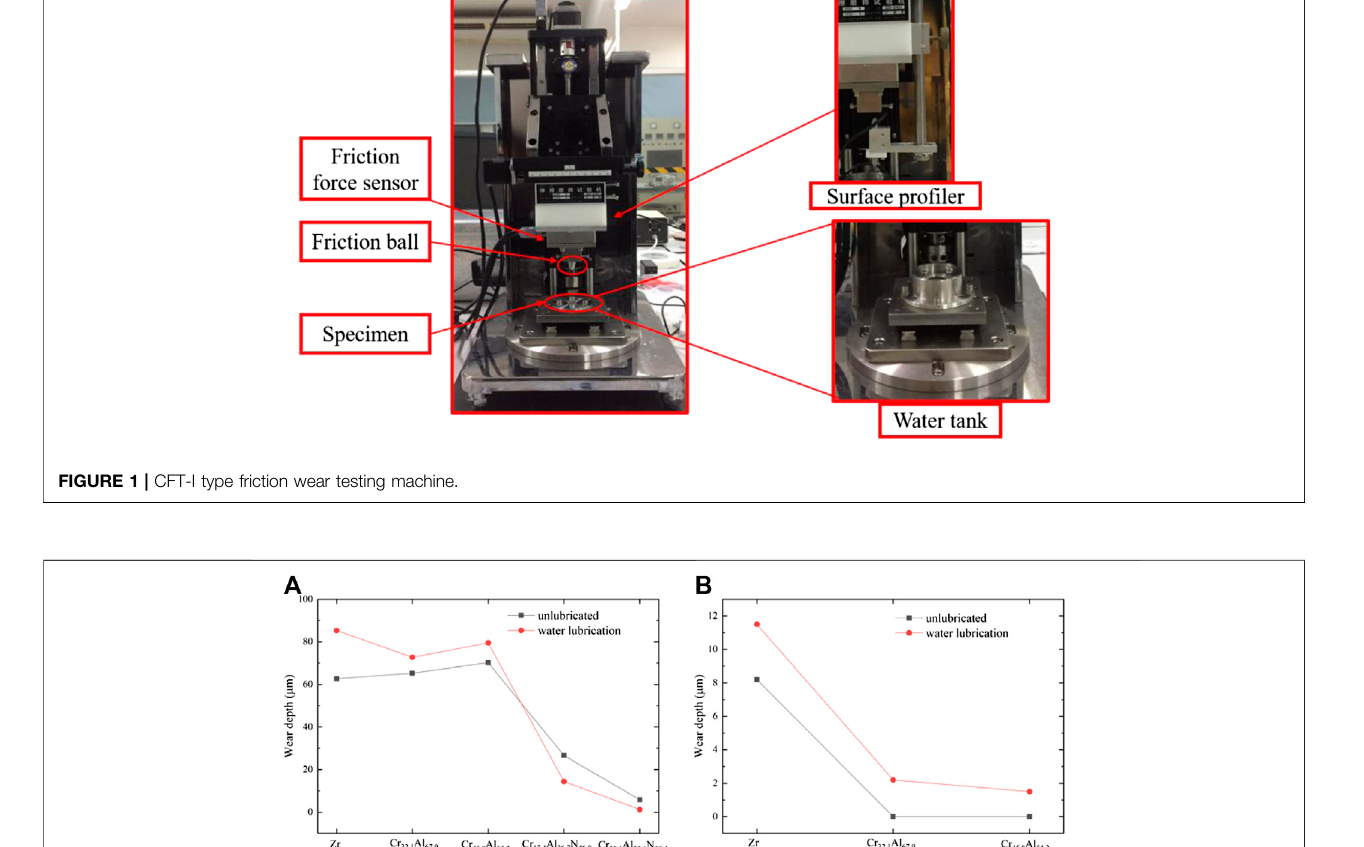
Frontiers in Energy Research |